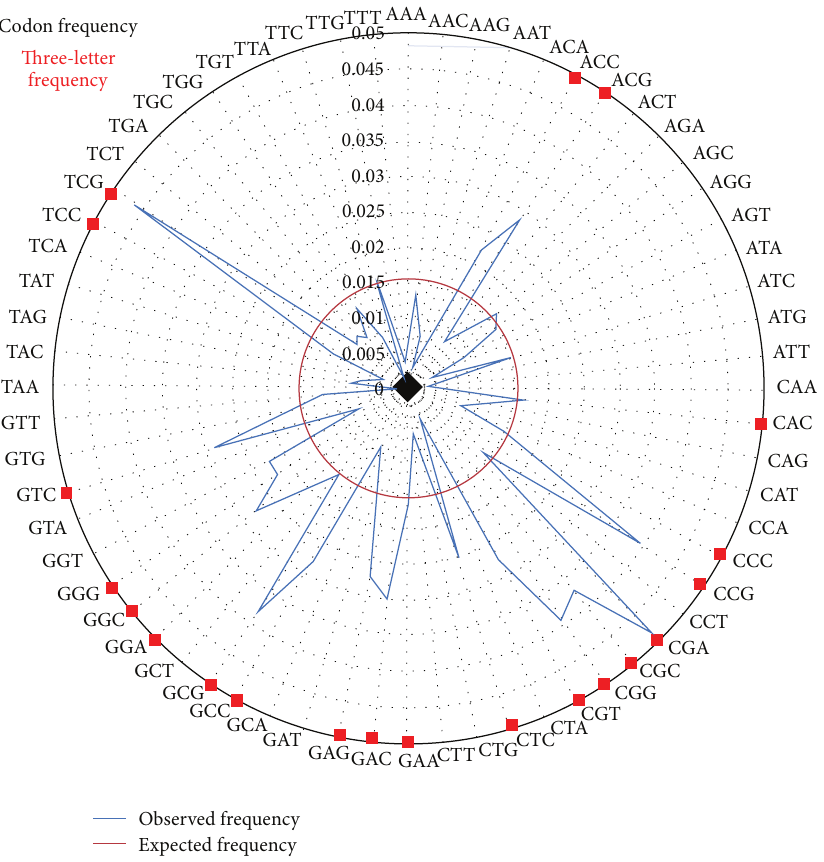
Figure 1: Radial graph displaying the three-letter codon frequency prediction of H. hamelinensis . Expected codon frequencies are indicated in the inner circle. Squares in the outer circle are indications are overrepresented